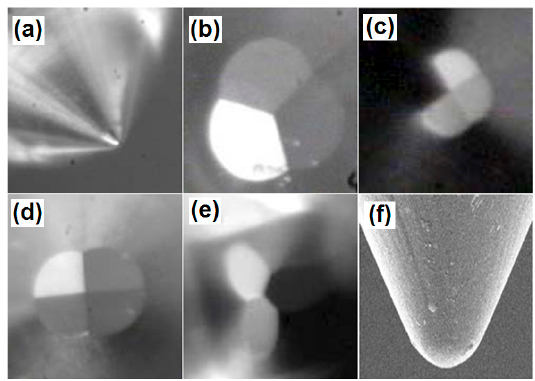
Figure 4. Shapes of different indenters: ( a ) Conical indenter; ( b ) Berkovich indenter; ( c ) Vickers indenter; ( d ) Knoop indenter; ( e ) Cube-corner indenter; ( f ) Spherical indenter [16].